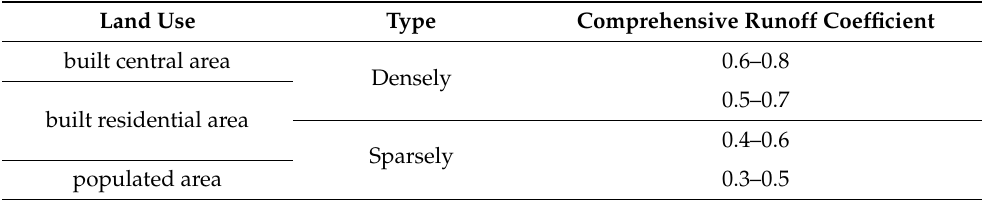
Table 5. Empirical values of the regional comprehensive runoff coefficient [17].